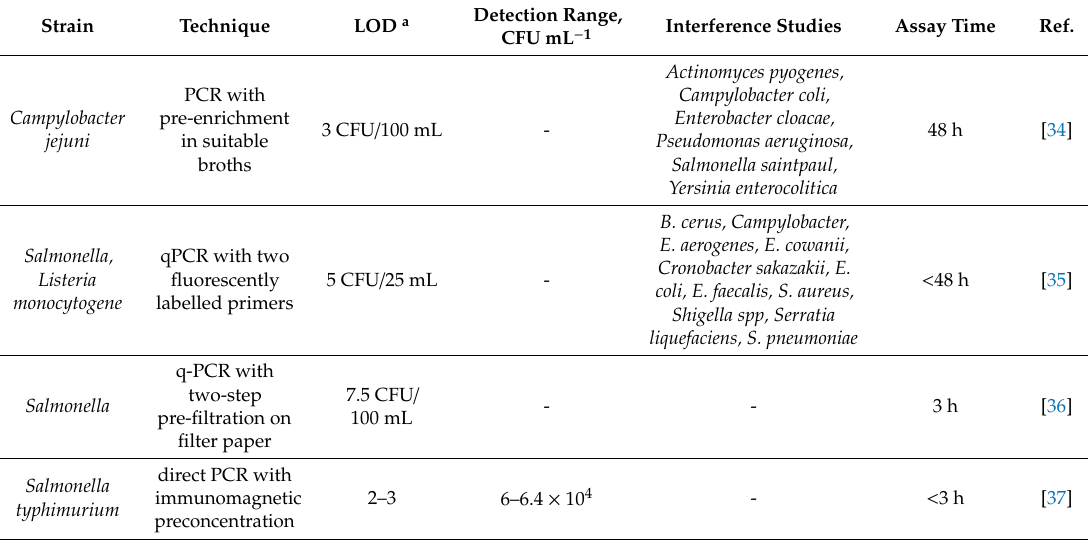
Table 1. Selected examples of nucleic acid-based optical biosensors for